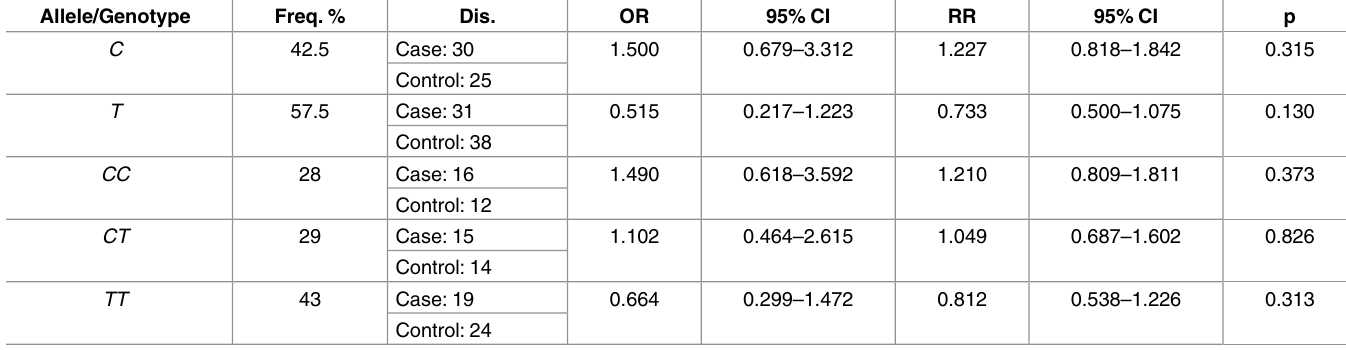
Table 3. Allele and genotype analysis of the ABCB1 gene polymorphism (rs10276036C/T) . Allele/Genotype Freq. %